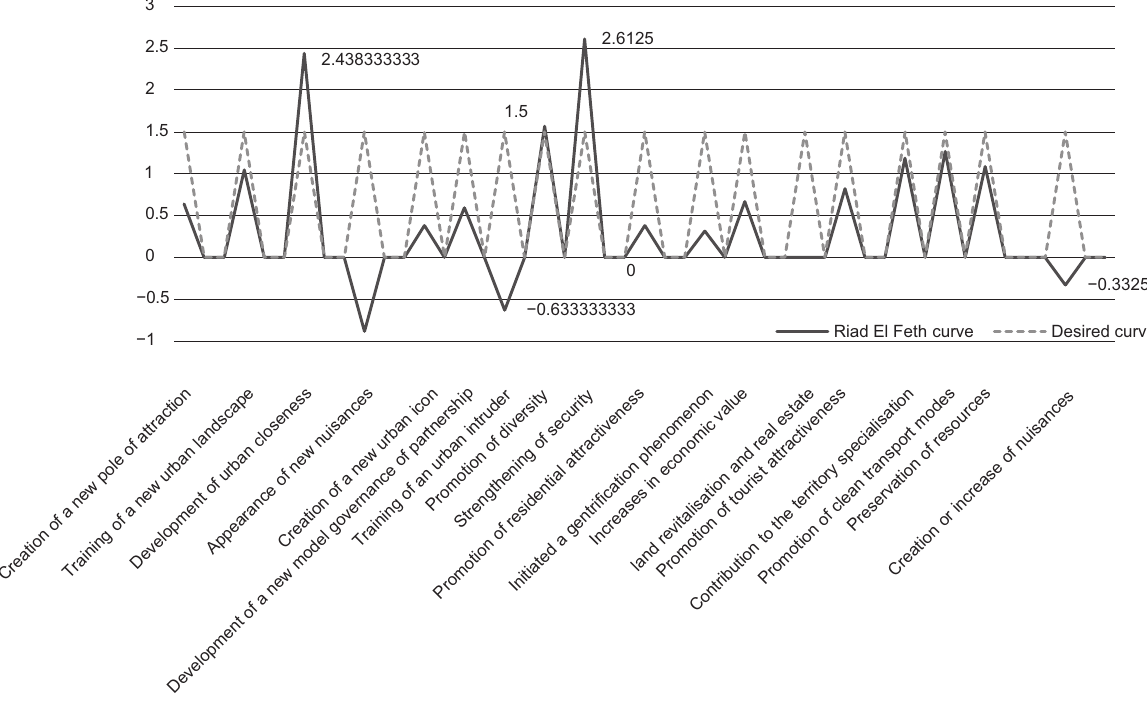
Fig. 6. The positive contamination curve for the Riad El